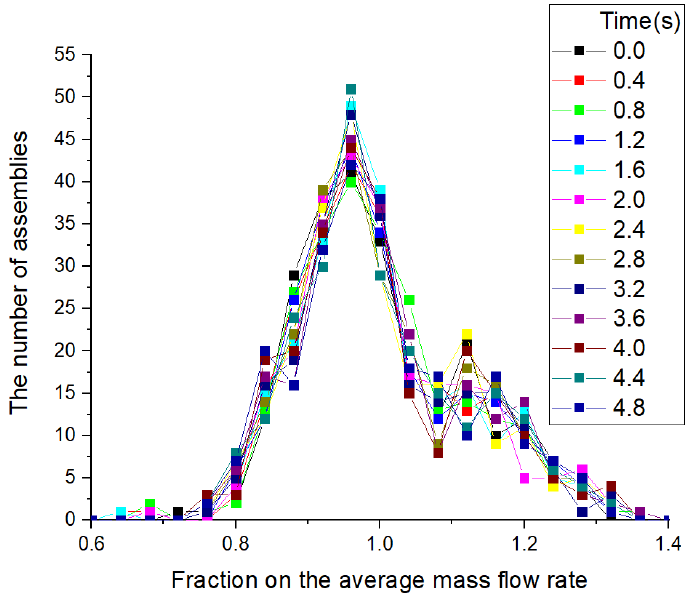
Figure 6. The distribution of the core inlet flow for each assembly. Figure 7 shows the range of core inlet flow over transient time to determine the un- certainty of the core flow asymmetry. As final values of the uncertainty, a mean value of 1.0 and a standard deviation of 0.230 were identified with a normal distribution. At 2.1 s, when the DNBR showed a minimum value from the system results, the fraction range of core inlet flow calculated by the CFD was from 0.699 to 1.325. Compared with the FSAR results of APR 1400, the total inlet flow into the entire core was more conservative than that of the MARS-KS results, because the FSAR assumed there was no flow in both direc- tions as soon as the transient initiated. However, given the reverse flow rate bypassing the core immediately after the accident, the MARS-KS results could be smaller than the FSAR values with respect to the inlet flow to a fuel assembly. In other words, when the reverse flow of core inlet flow was more realistic, it could be concluded that the DNBR at fuel assemblies of the FSAR was likely to be less conservative. Based on the uncertainty range predicted by CFD, the one side Wilks [19] formula was applied, and the uncertainty tool produced 124 input data to achieve 95% reliability and 95% accuracy of the DNBR. The reason for the use of the one side Wilks formula was that a smaller core inlet flow led to a decrease of the DNBR. The detailed theory can be found in the reference [19]. Therefore, 124 inputs using the uncertainty range on the core inlet flow would be used for the calculation of the sub-channel, with results in meaningful statistics.